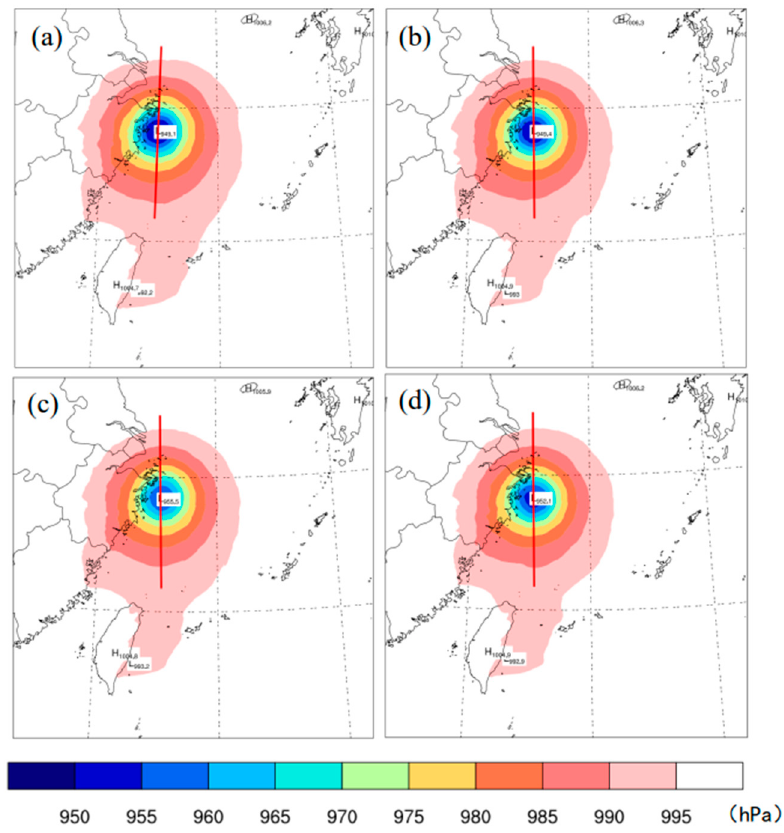
Figure 4. The sea level pressure from CTRL ( a ), FY3_a ( b ), FY3_d ( c ) and FY3_m ( d ) (unit: hPa, the red line is the cross line of Figure 5).